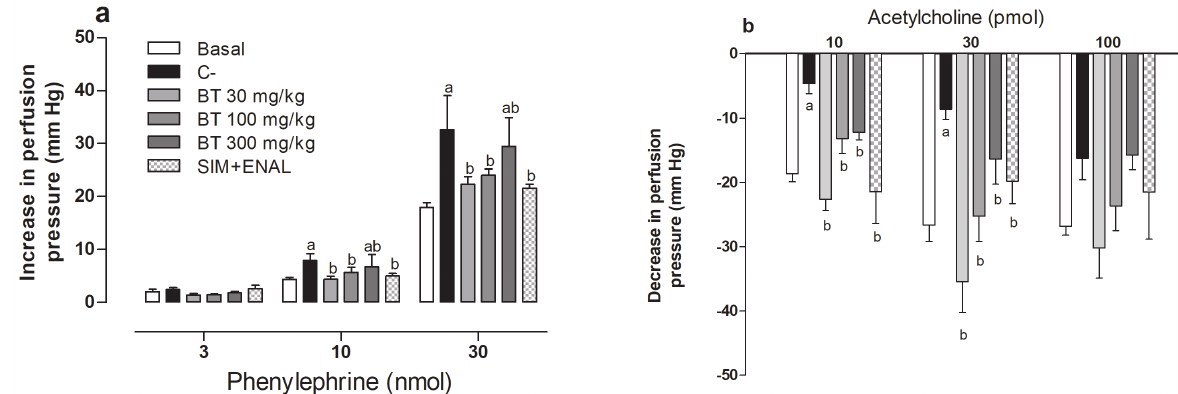
Figure 2. Perfusion pressure (mmHg) after an infusion of phenylephrine (a) and acetylcholine (b) in normotensive, non-dyslipidemic, and non-smoker Wistar rats (basal group) and hypertensive, dyslipidemic, and smoker Wistar rats that were treated with vehicle (negative control [C–]), Baccharis trimera (30, 100, and 300 mg/kg), and simvastatin + enalapril (SIM+ENAL). n = 8/group. The data are expressed as mean ± SEM. a p < 0.05, vs . basal; b p < 0.05, vs . C– (Kruskal-Wallis test followed by Dunn’s post hoc